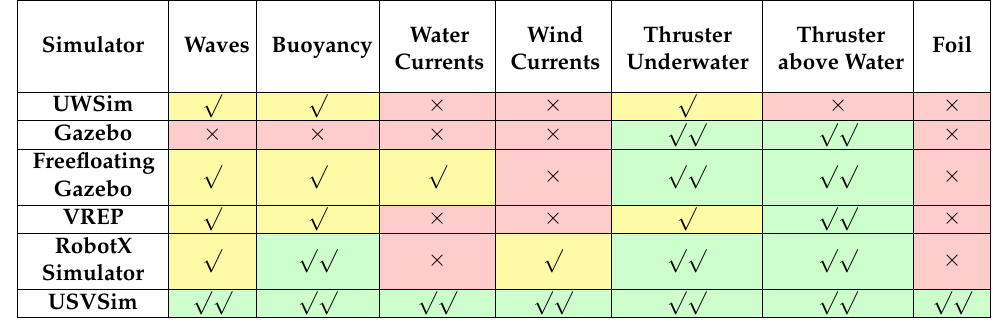
Table 1. Physical fidelity of multiple Unmanned Surface Vehicle